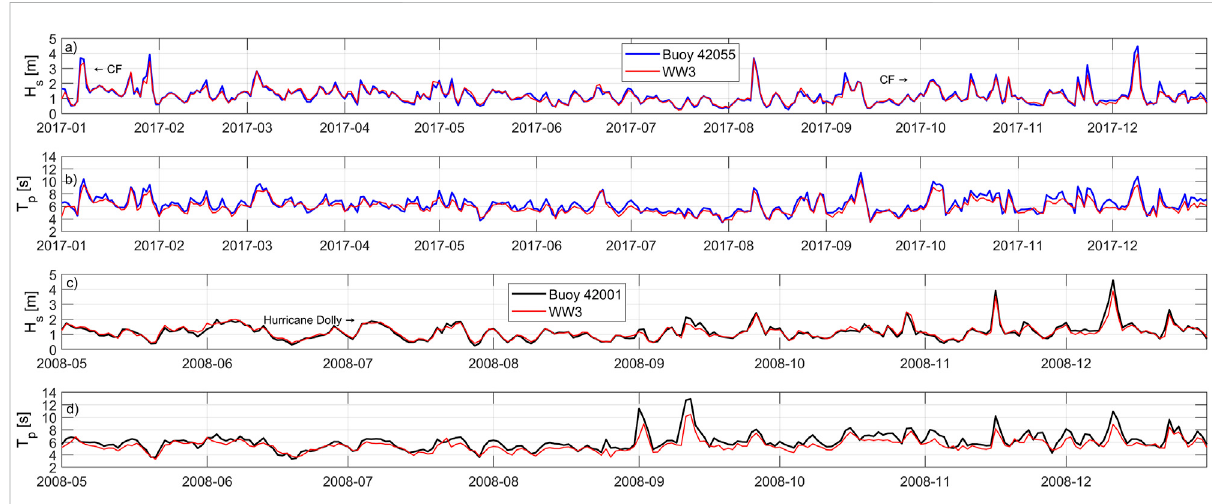
FIGURE 4 Time series of modelled and measured (buoys 42,055 and 42,001) signi fi cant wave heights and peak periods.